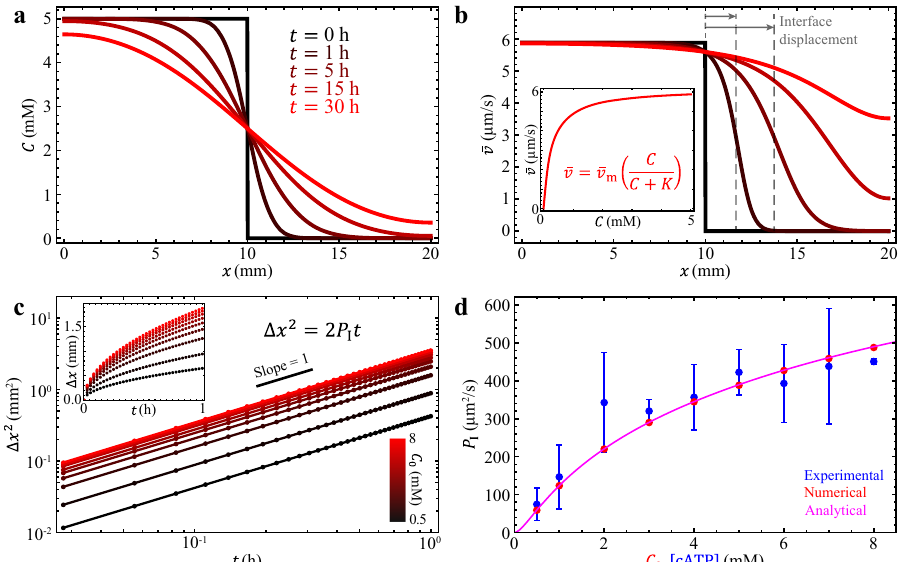
Fig.3|(Modelingresults)Fick ’ slawofdiffusionandMichaelis-Mentenkinetics concentration C 0 (see Supplementary Note 3 for derivation of Δ x 2 / t ). capturesthe diffusion-like mixing ofactiveand inactive fl uids. a The simulated distributionofATPconcentrationsstartsasastepfunction(black, t = 0h)andthen develops into a smoothed hill function (red, t = 30h) as ATP evolves from a one- sided distribution to a homogeneous state. b The model converts the ATP dis- tribution into the speed distribution of active fl uid via Michaelis-Menten kinetics: (cid:1) v = (cid:1) v ½ C = ð C + K Þ(cid:5) , where (cid:1) v µ m/s and K = 270 µ M (based on our previous m m = 6.2 studies 48 ).The corresponding meanspeed distribution of active fl uidevolvesfrom a step function distribution (black, t = 0h) to a near-constant function (red, t = 30h) (Supplementary Movie 2). Inset: The plot of the Michaelis-Menten equation (Eq. 4). c In the simulation, the diffusion-driven mixing process leads the squared interface displacement to be proportional to time, regardless of initial ATP